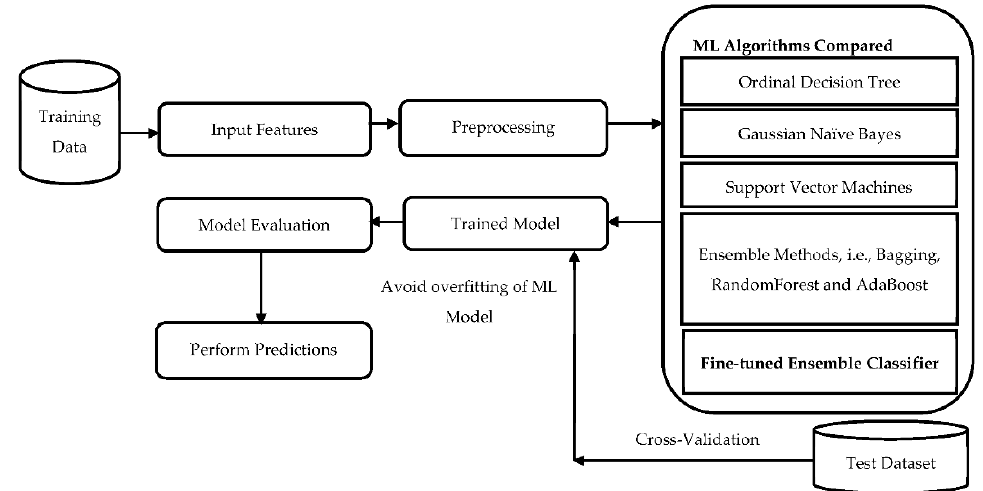
Figure 2. Workflow of the Fine-tuned Ensemble Classification model. Table 2. Sample instances of the COVID-19 dataset